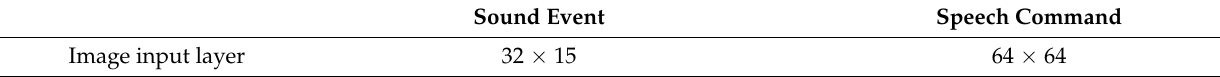
Table 1. CNN architecture used for the sound event and speech command